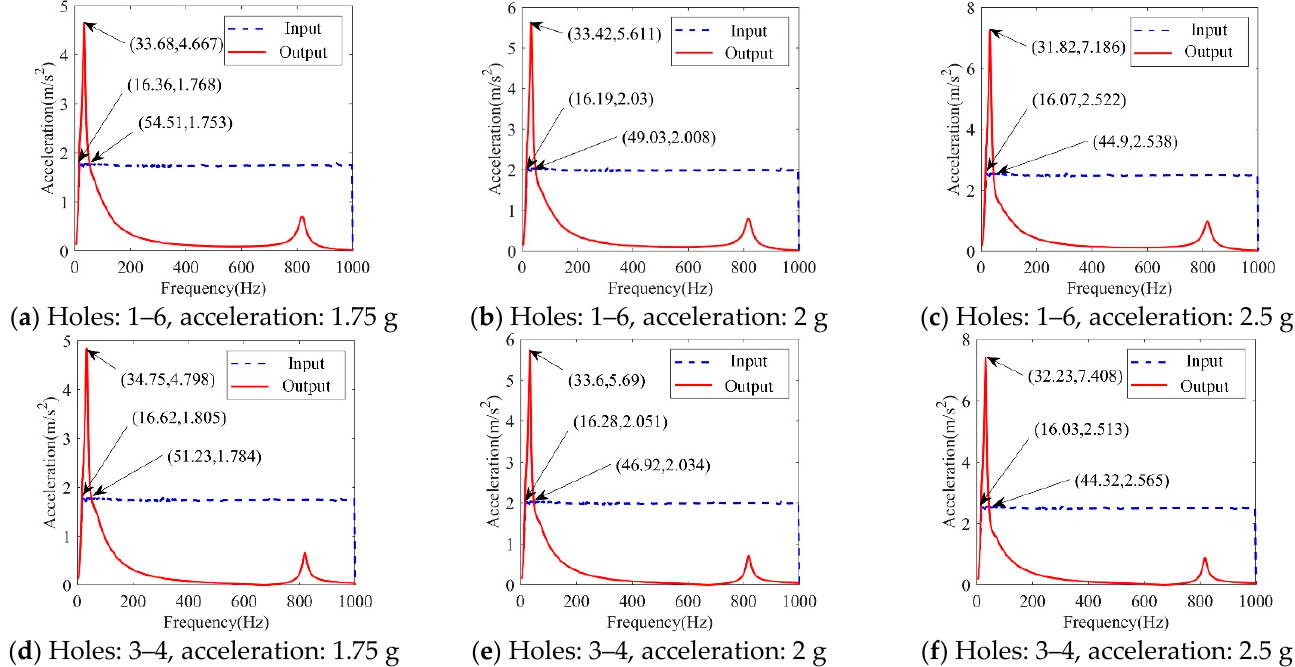
Figure 12. Dynamic sweep frequency experimental curves of 2D freedom vibration isolation systems with different distances. Table 4. Experimental results of the dynamic frequency sweep of vibration isolators with different distances.